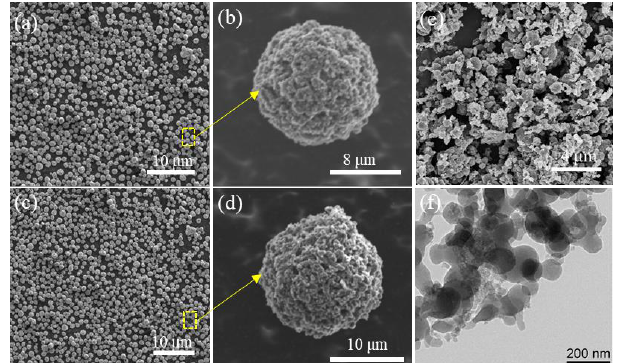
Figure 3. SEM images of ( a , b ) nB@F2603, ( c , d ) nB@F2603@CL-20 microspheres, and nB ( e ); TEM images of nB ( f ).